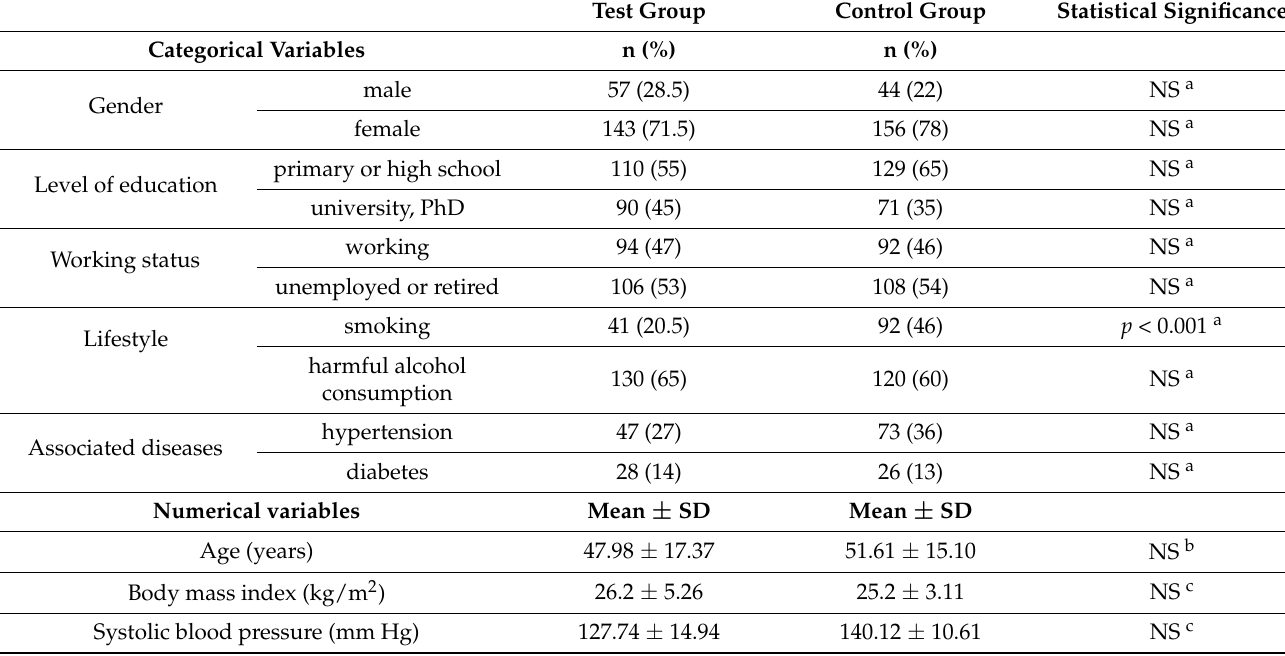
Table 2. Baseline characteristics of patients involved by